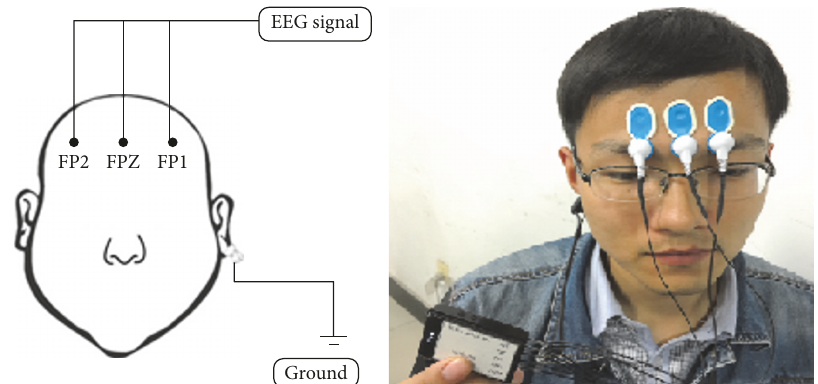
Figure 2: Pervasive three-electrode EEG acquisition system using Fp1, Fp2, and Fpz positions.